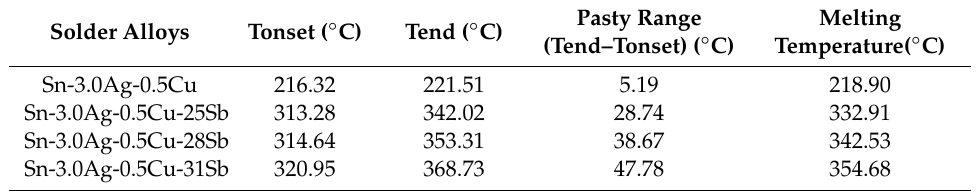
Figure 6. The direct scanning calorimetry (DSC) curve of the Sn-3.0Ag-0.5Cu- x Sb ( x = 25, 28, 31) solder alloy. Table 3. The solidus temperature (Tonset), liquidus temperature (Tend), and melting temperature of solder alloy from DSC heating